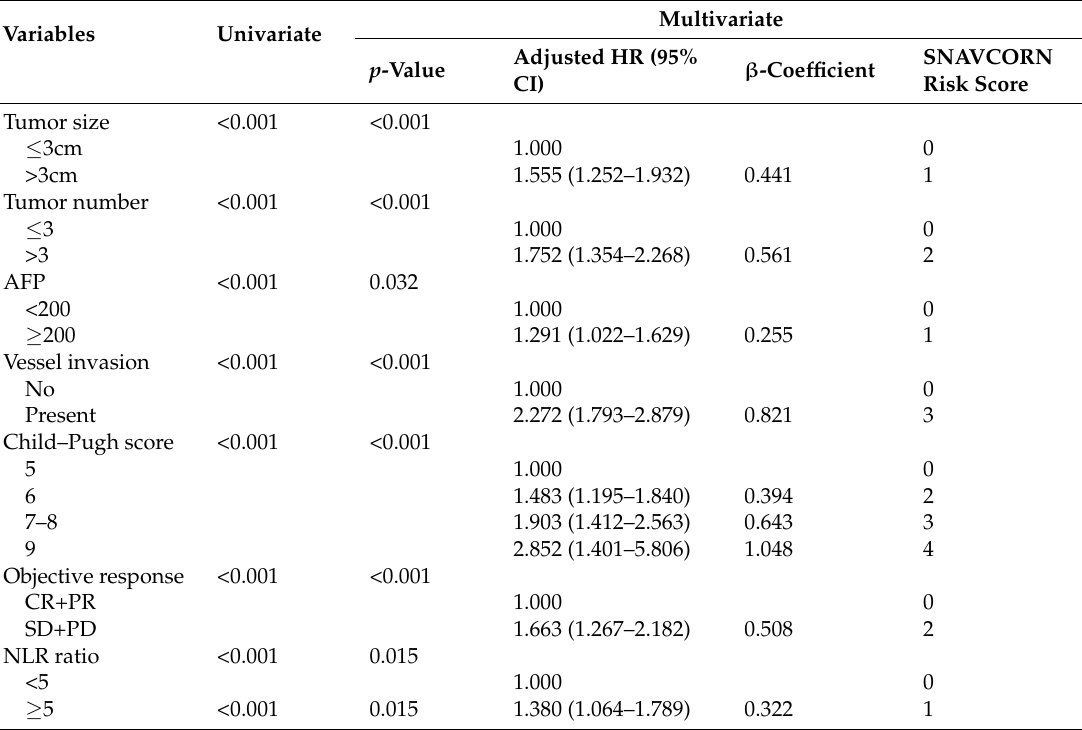
Table 2. Prognostic factors for overall survival and risk score calculation in the derivation cohort (n =